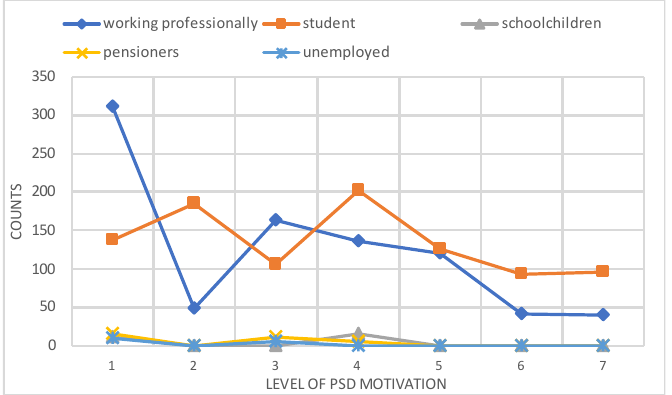
Figure 12. Interaction between the level of PSD and the professional activity of the respondents.